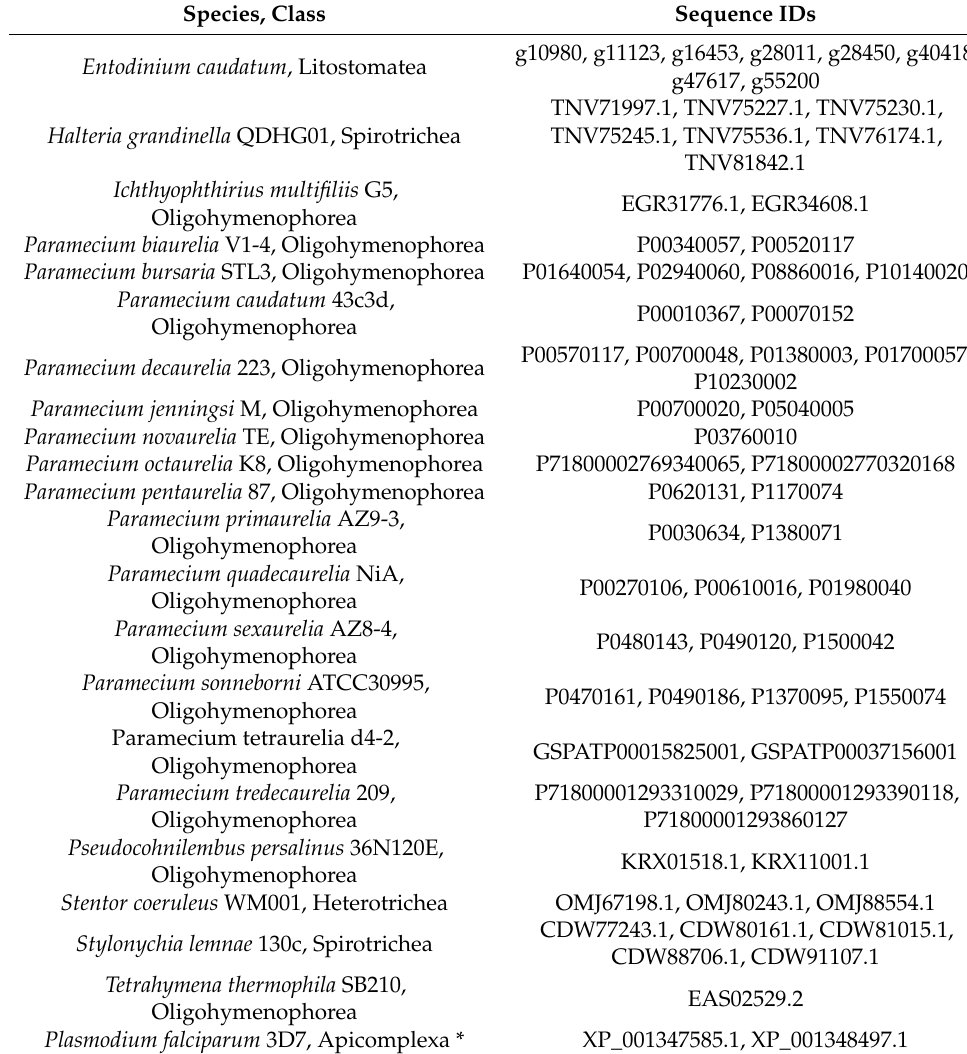
Table 1. Listing of sequences in orthogroup OG0001068. The sequences listed here are identified as CaMs according to their presence within the orthogroup of P. tetraurelia CaM (GSPATG00015825001). The left column indicates the species to which the sequences shown in the right column belong. Along with the species name, the Class taxonomic rank is included, except in the one marked with an asterisk, which corresponds to Phylum. The sequences are represented by their accession numbers in the corresponding database (see text in Figure 1). Sequence